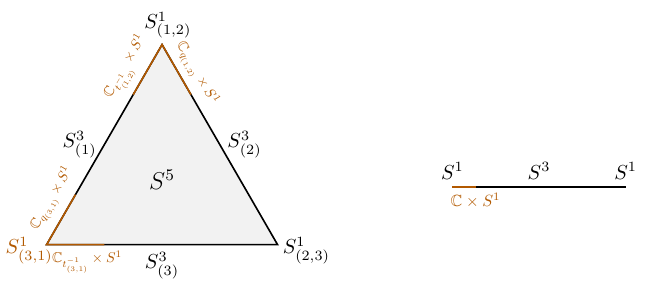
Figure 1. The squashed S 5 (resp. S 3 ) is a T 3 (resp. T 2 ) fibration over a solid triangle (resp. an interval). We also indicate several tubular neighborhoods of the S 1 are determined by the equivariant parameters.